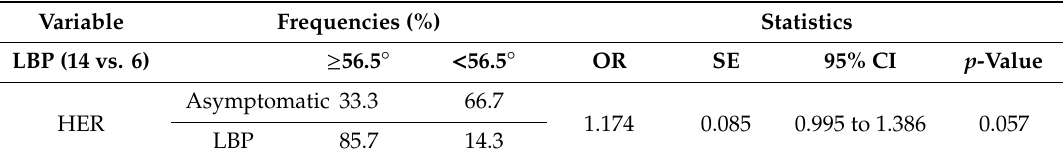
Table 4. Frequencies and logistic regression results: Intrinsic risk factors for lower back pain in the elite inline hockey players.